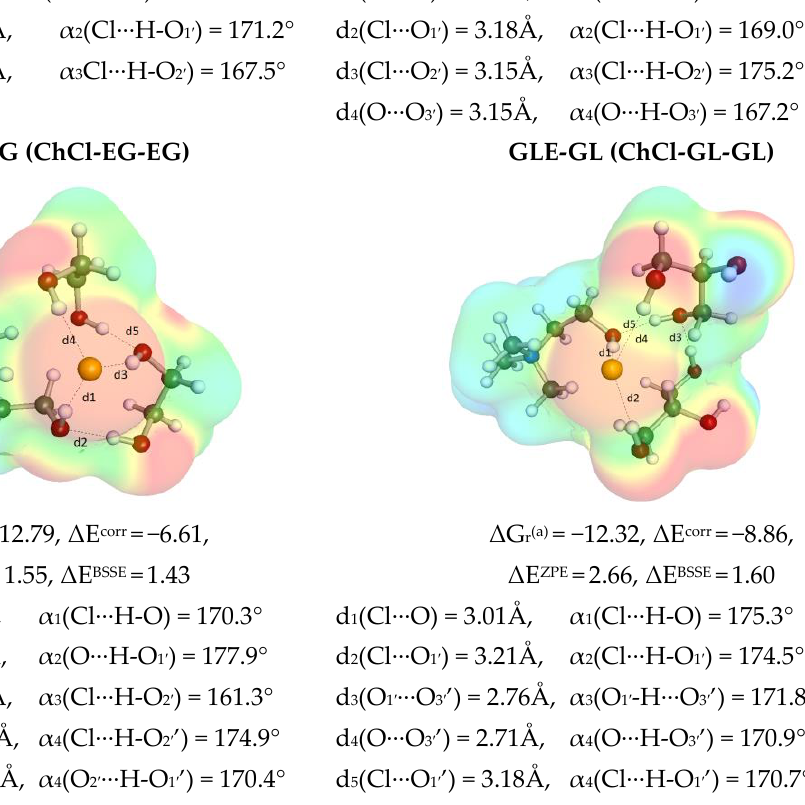
Figure 7. The most important geometric and energetic properties of intermolecular complexes iden- tified in ETA and GLE. All thermodynamic contributions are expressed in kcal/mol and represent relative values for X + Y = XY reactions, Δ G r(a) = the concentration-independent value of Gibbs free energy of reaction estimated in COSMOtherm using RI-BP86/def2-TZVPD//BP97/def2-SVPD, Δ E corr = electron correlation computed at RI-MP2/def2-QZVPP//BP97/def2-SVPD level, Δ E ZPE = zero vibra- tional contribution computed at RI-BP97/def2-TZVPD//BP97/def2-SVPD level and Δ E BSSE = geomet- ric based counterpoise correction BSSE DFT-C//BP97/def2-SVPD.